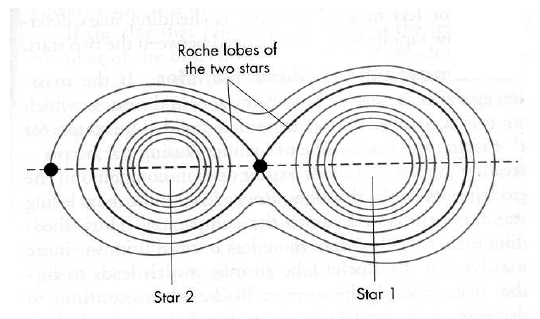
Fig.2: The Roche lobe and quipotential